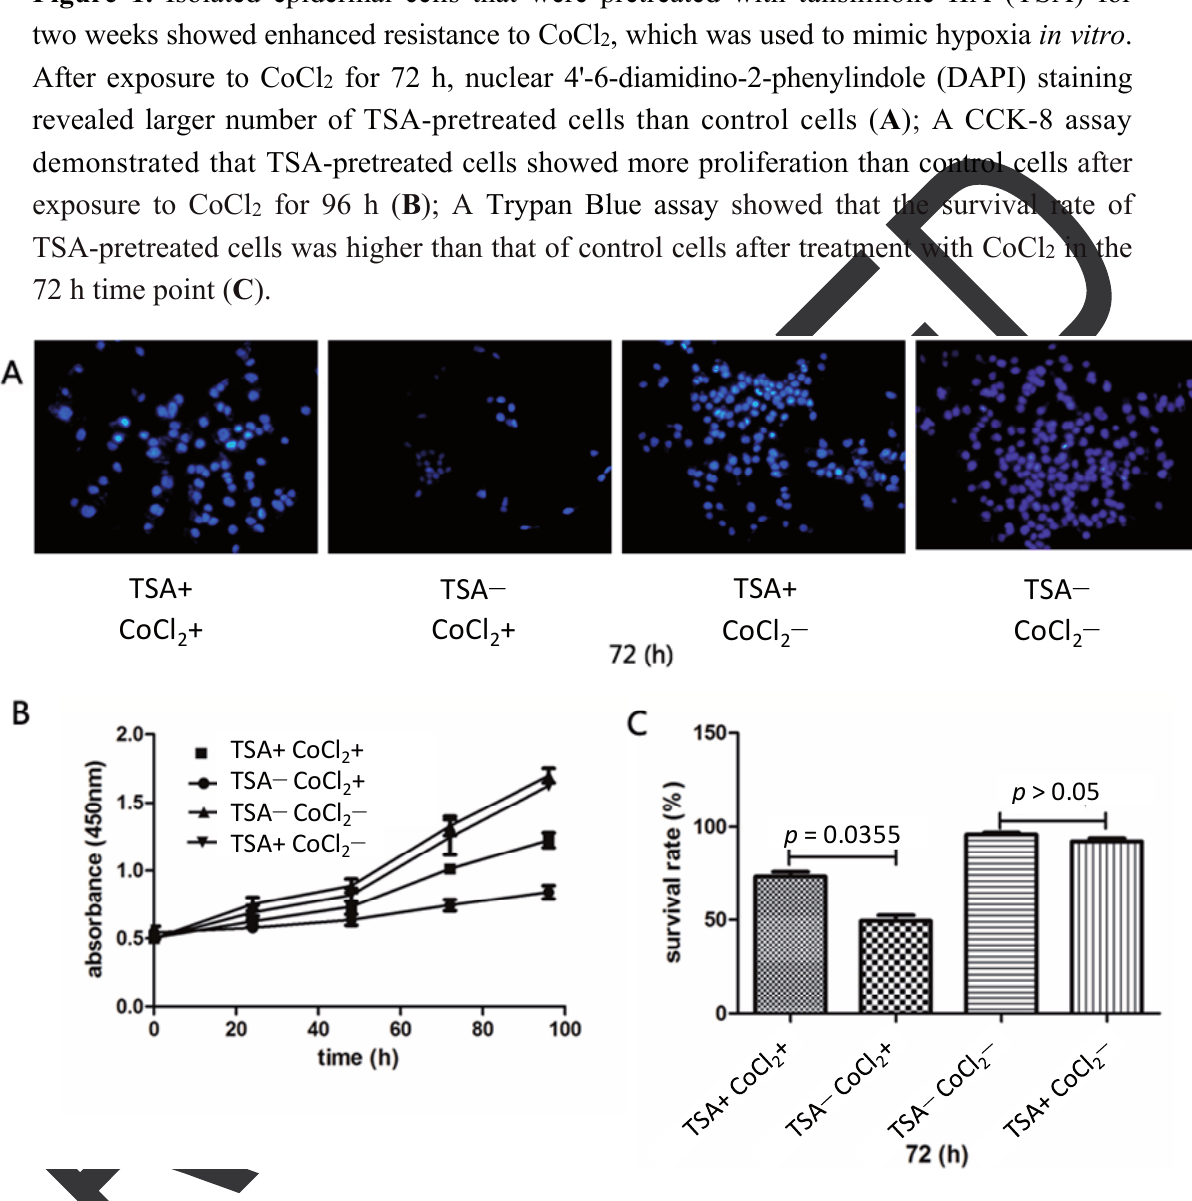
Figure 1. Isolated epidermal cells that were pretreated with tanshinone IIA (TSA) for two weeks showed enhanced resistance to CoCl 2 , which was used to mimic hypoxia in vitro . After exposure to CoCl 2 for 72 h, nuclear 4'-6-diamidino-2-phenylindole (DAPI) staining revealed larger number of TSA-pretreated cells than control cells ( A ); A CCK-8 assay demonstrated that TSA-pretreated cells showed more proliferation than control cells after exposure to CoCl 2 for 96 h ( B ); A Trypan Blue assay showed that the survival rate of TSA-pretreated cells was higher than that of control cells after treatment with CoCl 2 in the 72 h time point ( C